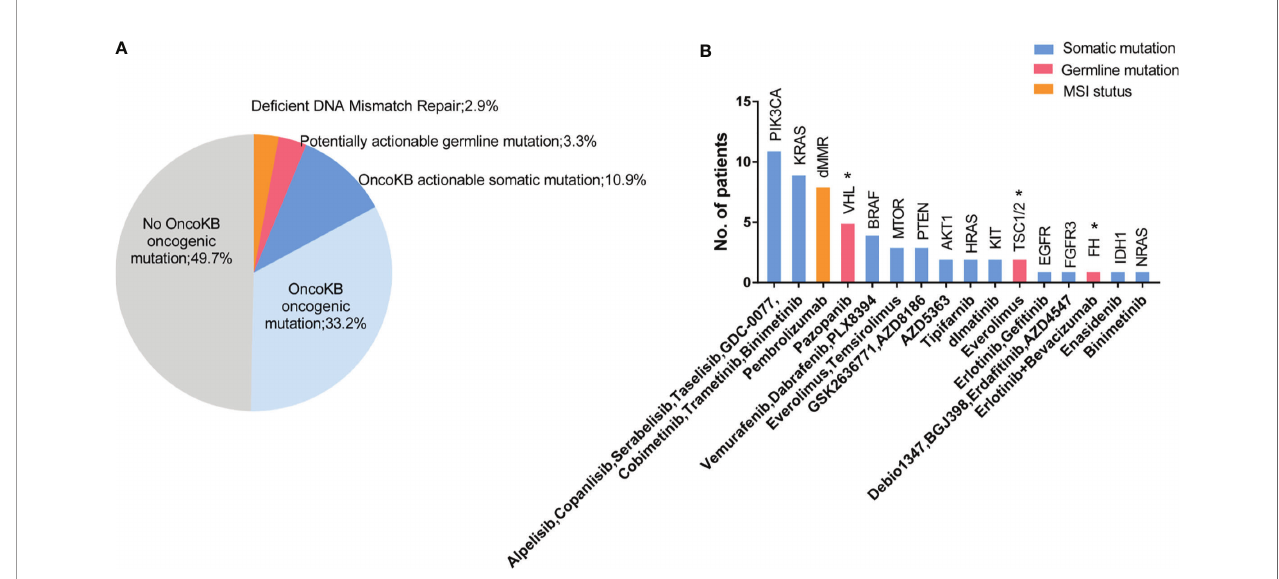
FIGURE 4 | Actionable alterations identi fi ed in tumors and germline sequencing. (A) 17.1% (47/274) of patients had a potentially actionable genomic alteration, including 10.9% (30/274) somatic alteration, 3.3% (9/274) germline, and 2.9% (8/274) with dMMR signature. 33.2% of patients had OncoKB identi fi ed oncogenic mutations without known potentially actionable alterations, and 49.7% of patients were absent with known driver mutations. (B) Number of patients with mutations in putative actionable target genes based on OncoKB databases and NCCN guidelines with candidate drugs listed below. VHL , TSC and FH were approvel/indicated for RCC base in NCCN guideline, which were markerd with an “ * ”